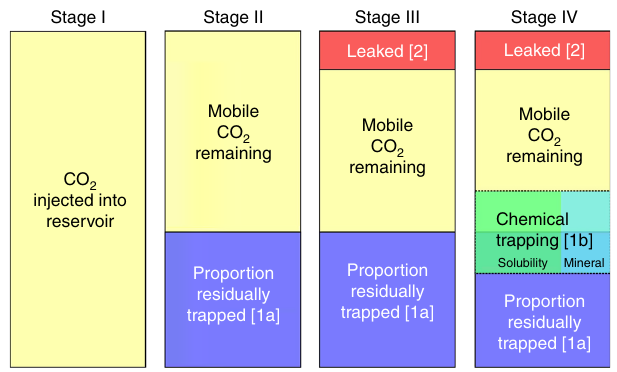
Fig. 2 Modelling stages computed by the Storage Security Calculator. The immobilisation and leakage models described in Fig. 1 are integrated in the Storage Security Calculator to compute the proportion of remaining mobile CO 2 in the subsurface in four stages. I) The total amount of CO 2 injected into reservoir is computed (based on the storage target). II) The amount of CO 2 immobilised by residual trapping is calculated (residual trapping immobilisation model – [1a]). III). The amount of CO 2 leaked from the reservoir (and, for simplicity, assumed to reach the atmosphere) is calculated via the leakage model. IV) The amount of CO 2 immobilised by chemical trapping (chemical trapping immobilisation model) is calculated as a function of free-phase (i.e., both residual and mobile) CO 2 remaining in the reservoir. The calculations are carried out annually for each time-step of the model until there is no mobile CO 2 remaining, or until 10,000